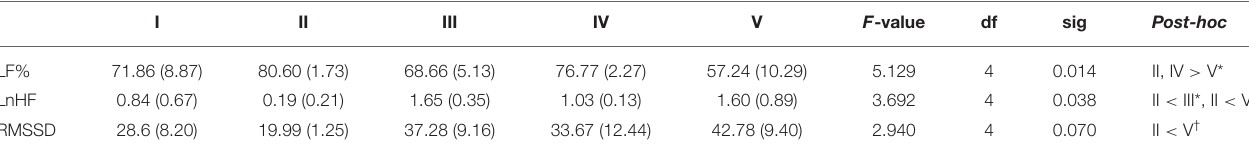
TABLE 3 | Mean differences and standard deviations of HRV parameters by work shifts.